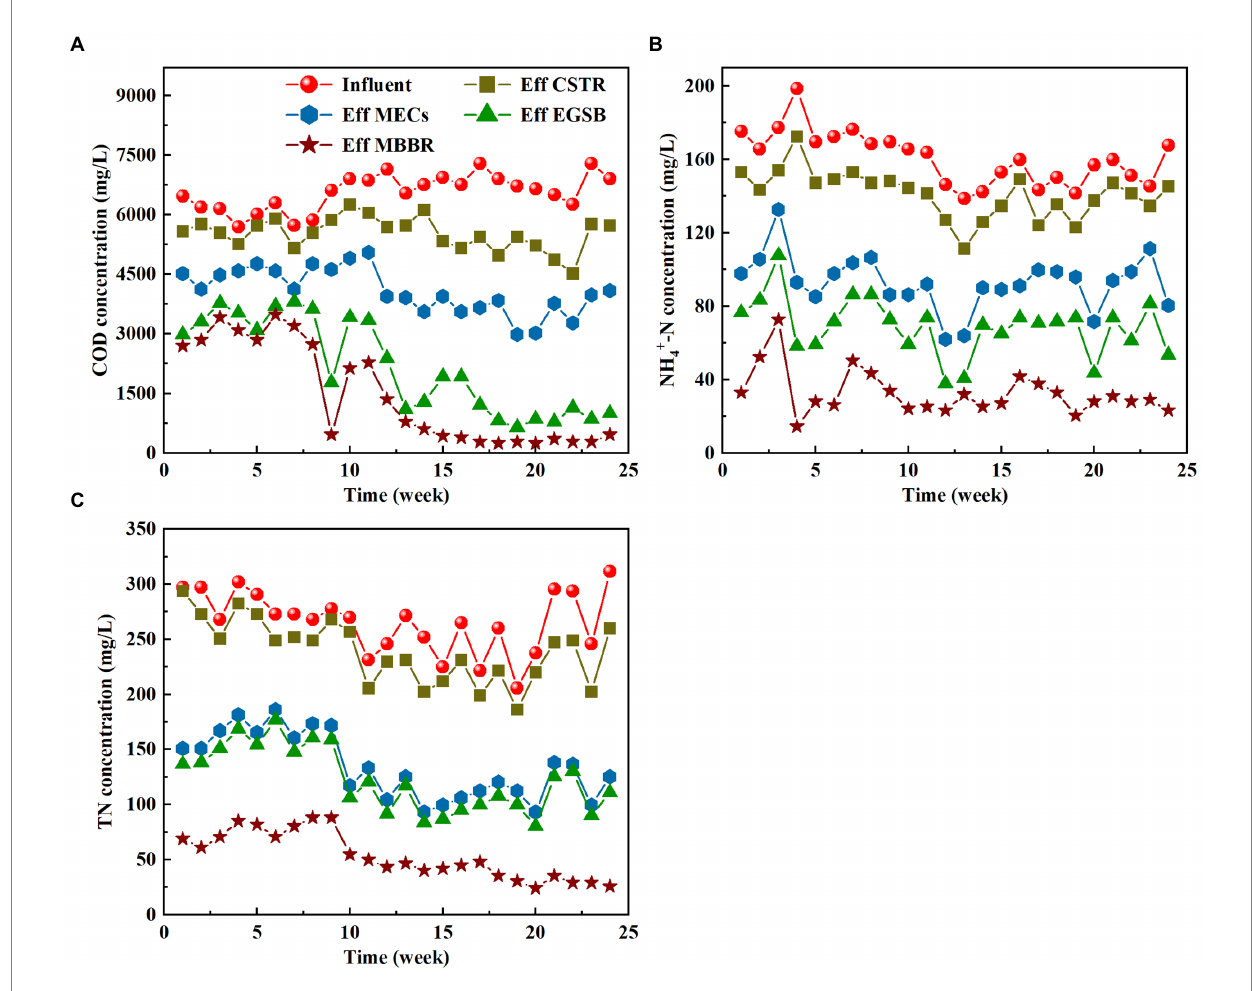
FIGURE 2 Variation characteristics of COD ( A ), NH4+-N ( B ) and TN ( C ) in different process sections.